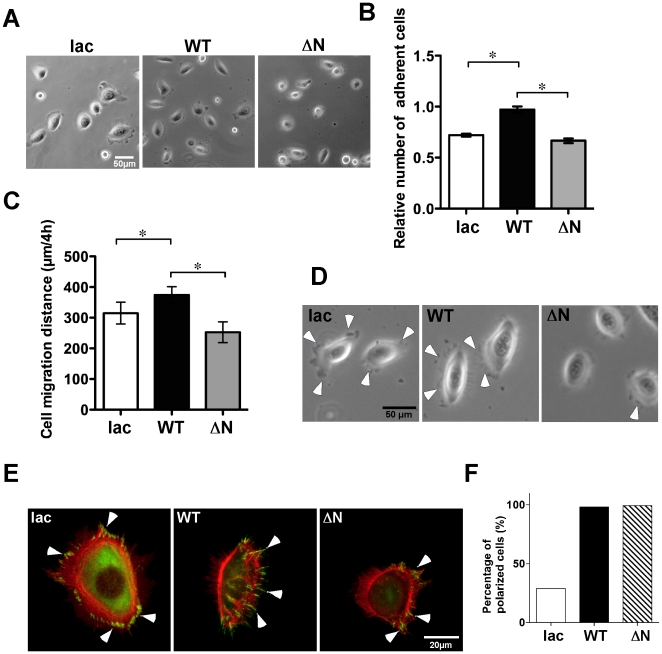
Effects of ΔNß4 integrin on the cellular activities on laminin-332 substrate.(A) Cell morphology of the indicated keratinocytes was photographed after cell spreading on laminin-332 substrate for 20 min. (B) The effect of ΔNß4 integrin on cell adhesion activity on 2 µg/ml of the laminin-332 substrate. The experiment was performed in triplicate thrice. *P<0.001 (one-way ANOVA, Bonferroni post test) vs. WT. (C) Effect of ΔNß4 integrin on the cell migration activity on laminin-332 substrate. The indicated keratinocytes in culture medium were plated onto dishes precoated with 2 µg/ml laminin-332, followed by incubation for 1 h. Cell migration was monitored by time-lapse microscopy, as described in “MATERIALS AND METHODS.” Each bar represents the mean ± S.D. of the migration distance of ten cells in each assay in three independent experiments. *P<0.001 (one way ANOVA, Bonferroni post test) vs. WT. (D) Cell morphology of each keratinocyte during migration. (E) The indicated keratinocytes in culture medium were plated onto dishes precoated with 2 µg/ml laminin-332. After incubation for 24 h, cells were fixed and stained with a paxillin mAb and followed by secondary Ab and phalloidin for visualizing paxillin (green) and actin filament (red). (F) Polarized cells were determined and counted as described in “MATERIALS AND METHODS.”